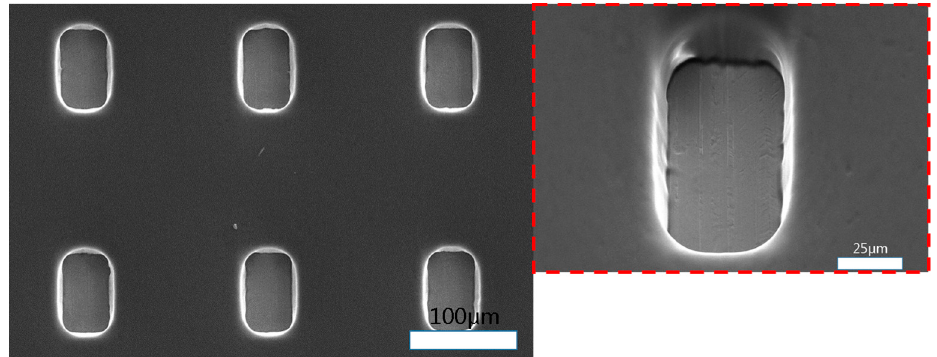
Figure 1. SEM image of DFR (Dry Film Resist) -coated Invar thin film.